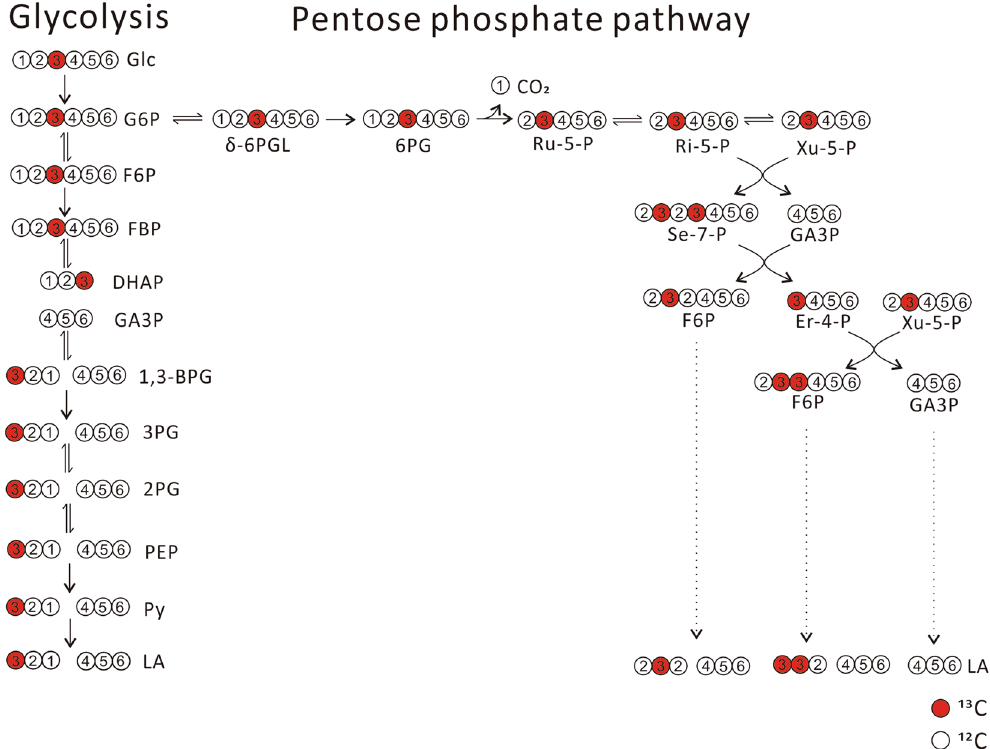
Figure 4. Metabolic pathways that generate various lactate isotopomers and isotopologues in cells, traced with [3- 13 C]glucose. In theory, when cells incubated with [3- 13 C]glucose, most glucose is converted to lactate directly through glycolysis, which results in equal amount of [1- 13 C]lactate that derived from glucose carbon 1, 2, 3 to lactate derived from glucose carbon 4, 5, 6. A fraction of glucose enters oxidative branch pentose phosphate pathway, cycles back to glycolysis through nonoxidative branch of pentose phosphate pathway, subsequently converts to lactate. Three major species, [1,2- 13 C 2 ]lactate, [2- 13 C]lactate, and lactate, were generated from nonoxidative pentose phosphate